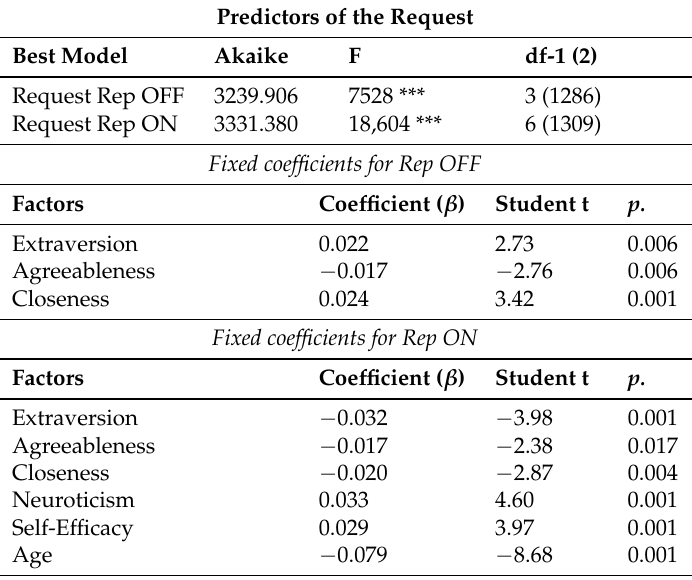
Table 5. GLMM 2. Socio-demographic and Psychological predictors of request behavior in each